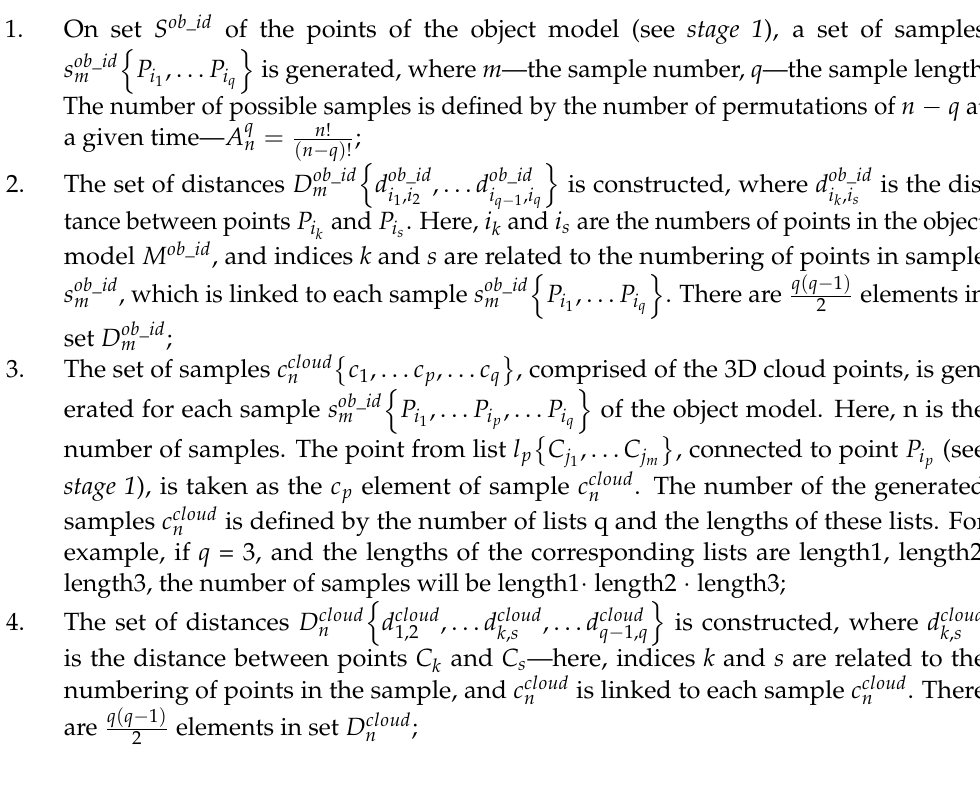
Figure 4. Points in min–max-shells in the 3D cloud, marked in black, are identified by the search algorithm as belonging to the SPS object.